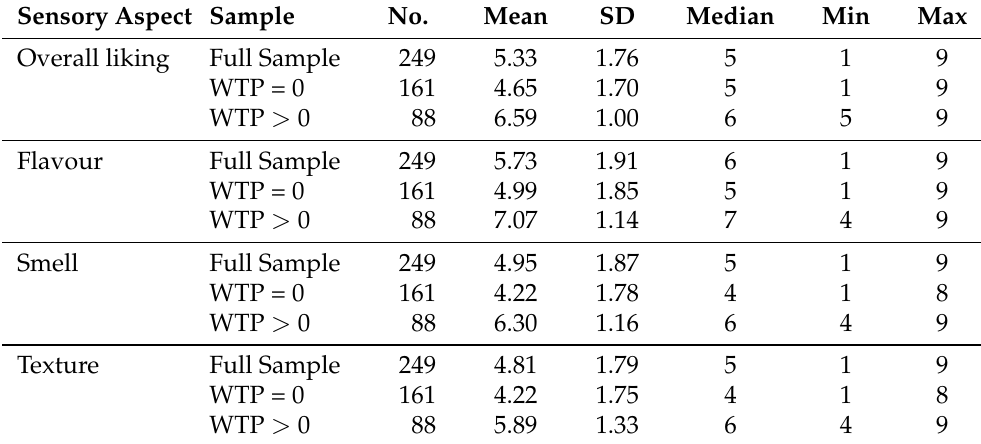
Table 3. Summary statistics of sensory hedonic scores *.